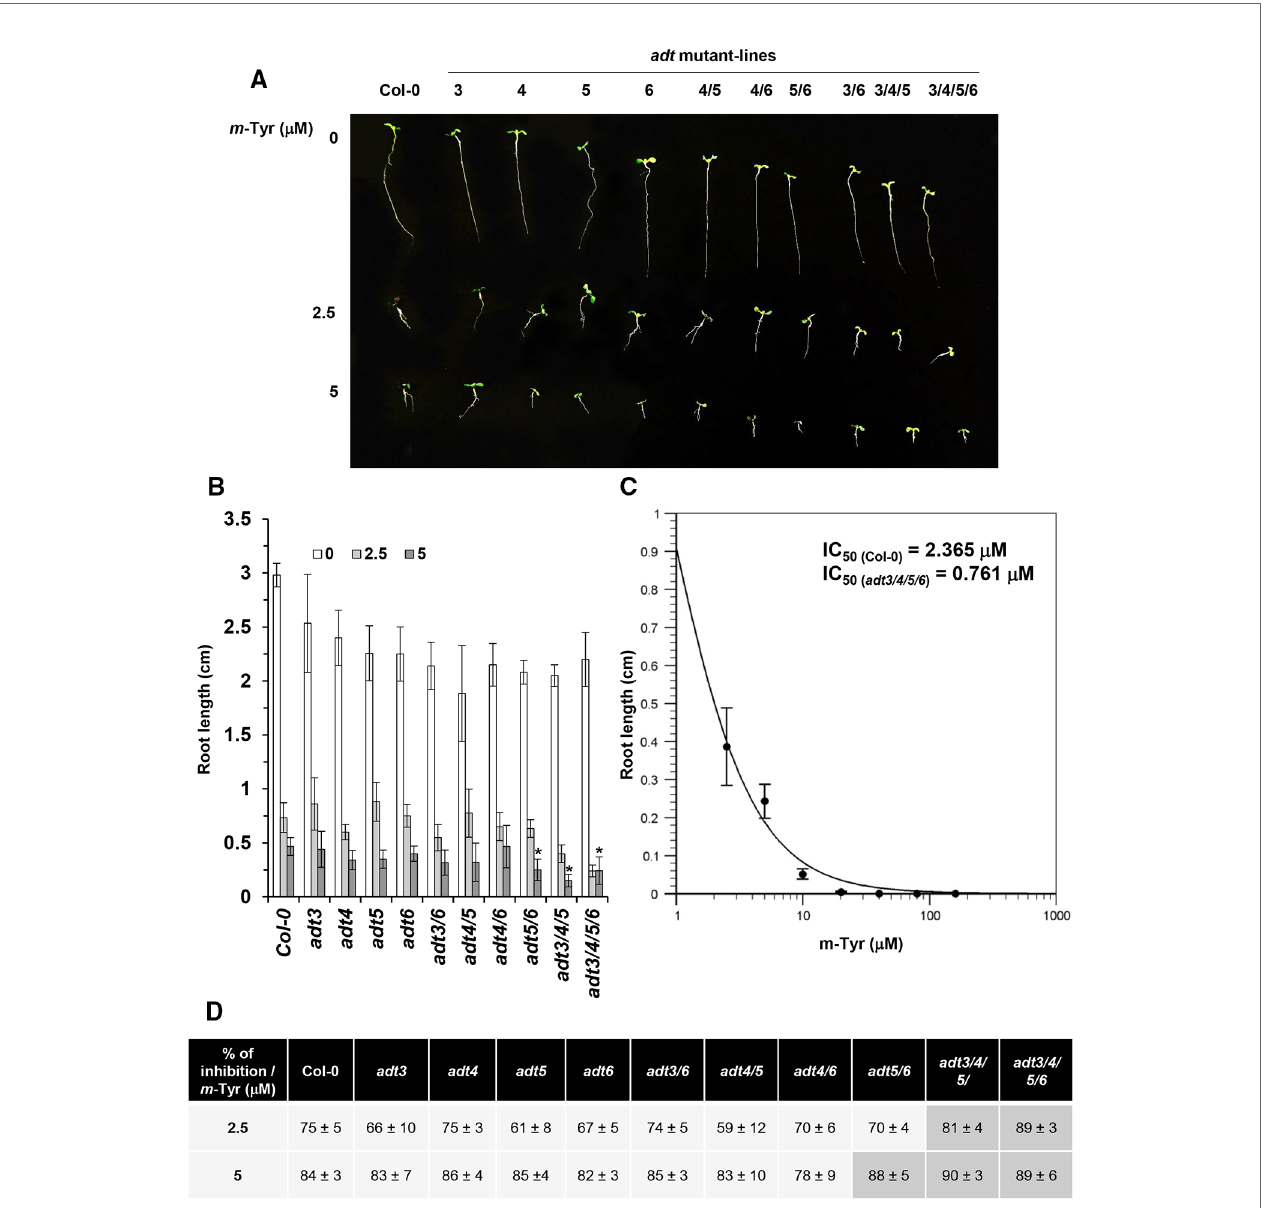
FIGURE 3 | The effect of m -tyrosine on Arabidopsis wild-type and single, double, triple, or quadruple adt knockout mutant-lines. (A) Seeds of Arabidopsis wild-type (Col-0) and homozygous adt mutant-lines (Chen et al., 2016; Höhner et al., 2018) (generously provided by Prof. Jirong Huang, Shanghai Normal University) were germinated in Murashige and Skoog (MS)-agar plates in the absence or presence of different concentration of m -tyrosine (i.e., 0, 2.5, and 5 m M), as indicated in the panel. The fi gure show 5-day-old seedlings. (B) Measurements of the root lengths in 5-day-old Arabidopsis wild-type (Col-0) plants and adt mutants. (C) IC 50 of the quadruple adt3/4/5/6 mutant was calculated using the ‘ Quest-Graph ™ IC50 calculator' (https://www.aatbio.com/tools/ic50-calculator). (D) The effect of m -tyrosine (i.e., % of inhibition) on the relative root length ratios in 5-day-old wild-type (Col-0) plants and adt mutants. Bar in (panel A ) represents 1.0 cm. The values are means of three biological replicates with about 25 seedlings in each treatment. Error bars indicate one standard deviation. Asterisk in (panel B ) indicates a signi fi cant difference from 5 m M m -Tyr grown plants (Student's T-test, P ≤